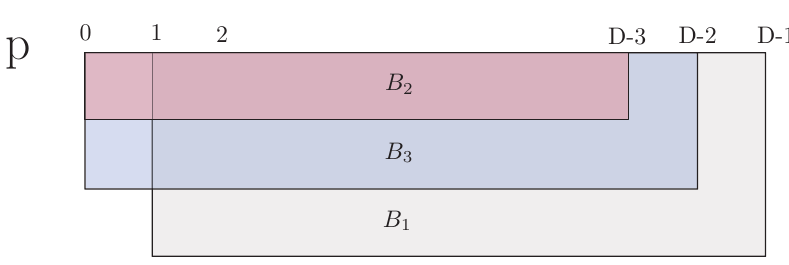
Figure 1: Existence conditions of the terms B 1 , B 2 and B 3 in the action that could be read from tab. (1). Figure 1 . Existence conditions of the terms B table For B instead we should distinguish two cases, 2